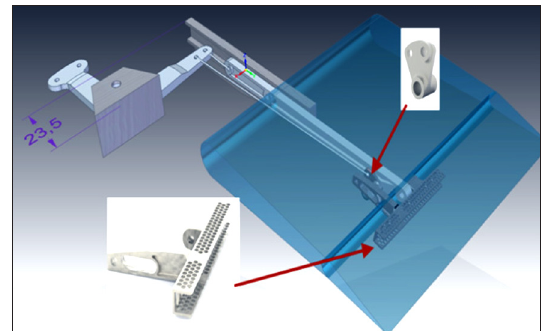
Fig. 8. Different positions of the VGMF in sailplane LAK-17B (Figure: K-E. Seegel)